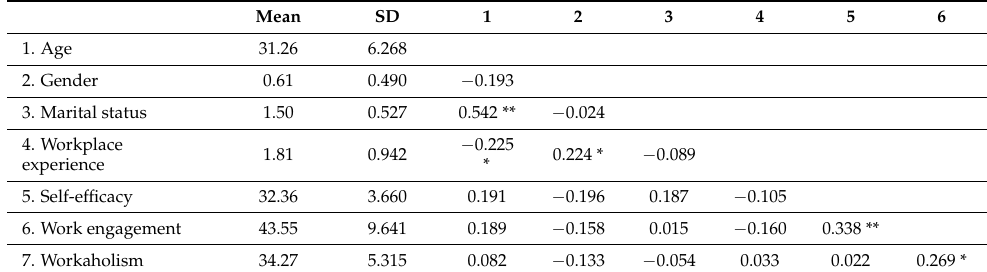
Table 3. Correlation table.